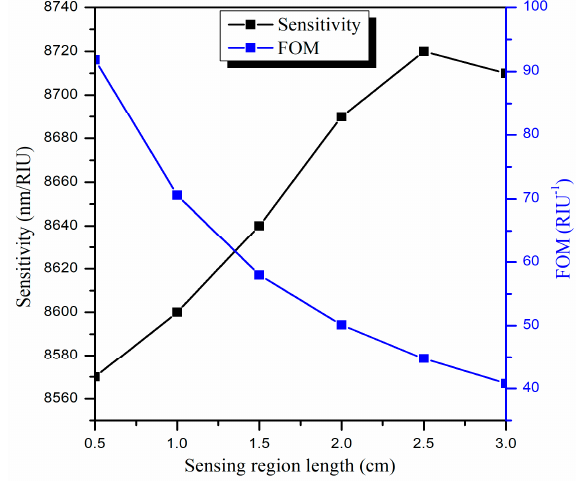
Figure 8. Variation in the sensitivity and figure of merit with various sensing region lengths (L) for the designed U-shaped LMR sensing probe.